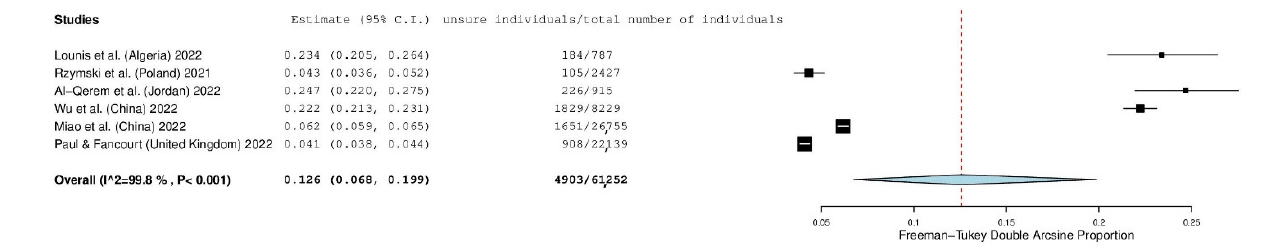
Figure 4. Forest plot of individuals reporting that they were unsure of their intention to accept a first COVID-19 booster dose. The size of black squares denotes the sample size, while the horizontal line through the square denotes the 95% confidence interval for the unsure proportion.